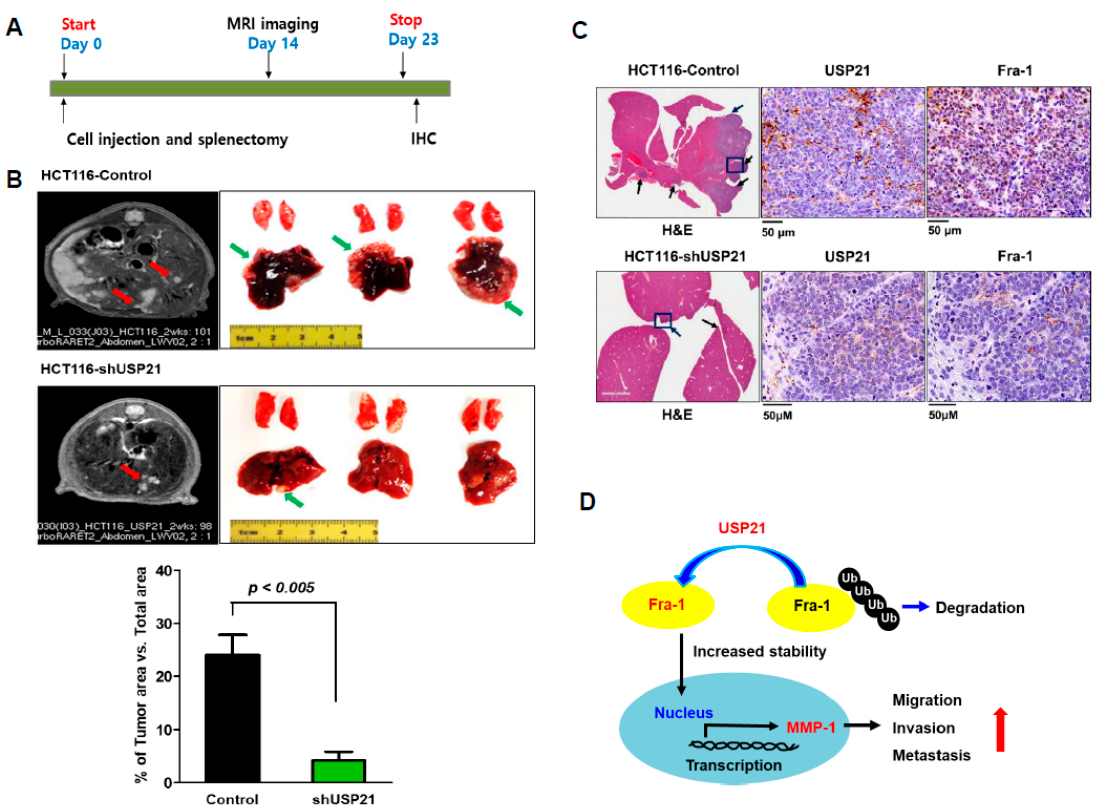
Figure 7. USP21 knockdown in colon cancer decreases in vivo metastasis. ( A ) The scheme of designed animal experiments. ( B ) Representative magnetic resonance images (MRIs) of tumors from HCT116- control and HCT116-USP21 knockdown groups at day 14 after intrasplenic injection (left). Developed tumors are marked by red arrows. Representative morphology of tumor formation in mouse liver